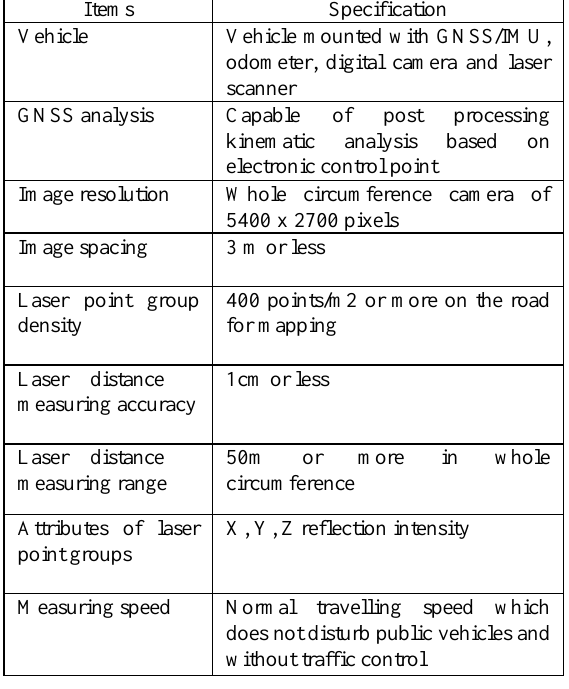
Examples of the data acquired: ① Distance from road edge to building ② Buildings exceeding elevation angle of 45o from